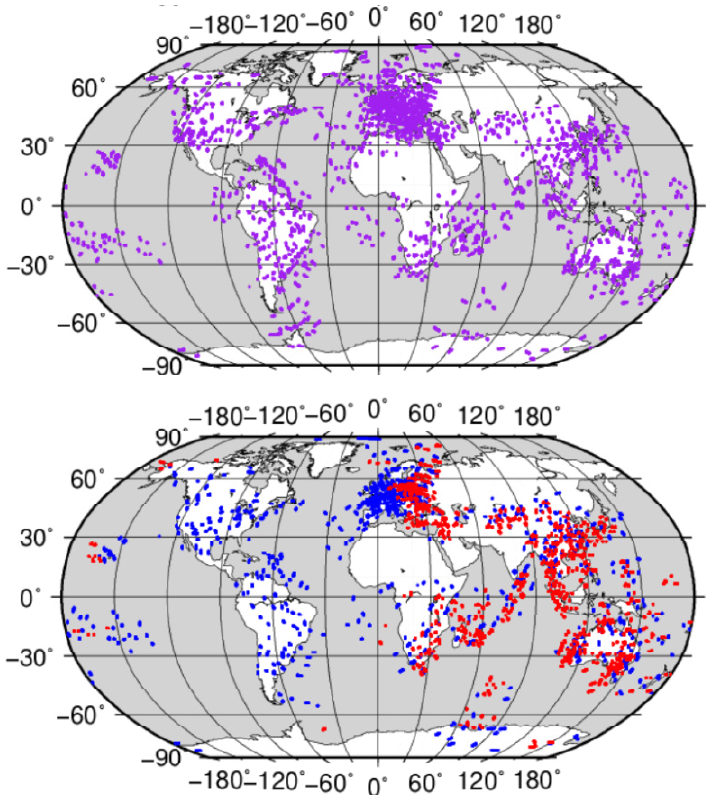
Figure 19. Intersecting pierce point (IPP) distributions of the GPS (purple dot), BSD2 (red dot), and BDS3 (blue dot) ionospheric observables for the periods between UTC 00:00 and UTC 00:15 on DOY